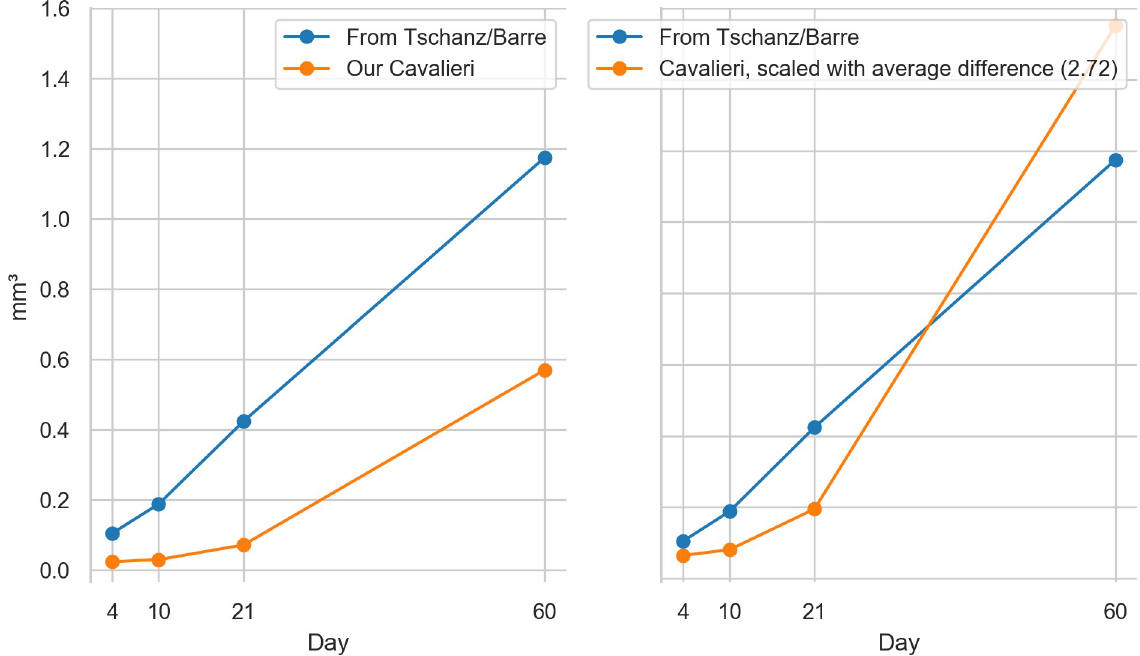
Fig 6. Plot of the mean acinar volumes. By dividing the parenchymal volumes of each lung estimated by Tschanz et al. (Table 1, [6]) by the mean number of acini estimated by Barre´ et al. [11] we can estimate the mean acinar volume for each measured time point (blue plot). We assessed the volumes of the acini by point counting (Cavalieri estimation, orange plot). Left: original data. Right: Our data, scaled by a linear correction factor. Our volumes of the acini are on average 2.07 times lower but show a similar increase over the studied period. While the estimation based on Tschanz et al. is from the entire right middle lobe and on Barre´ et al. globally for the whole organ, our estimation is solely based on the stereological analysis of the acini in the lower medial tip of the right lower lung lobe.